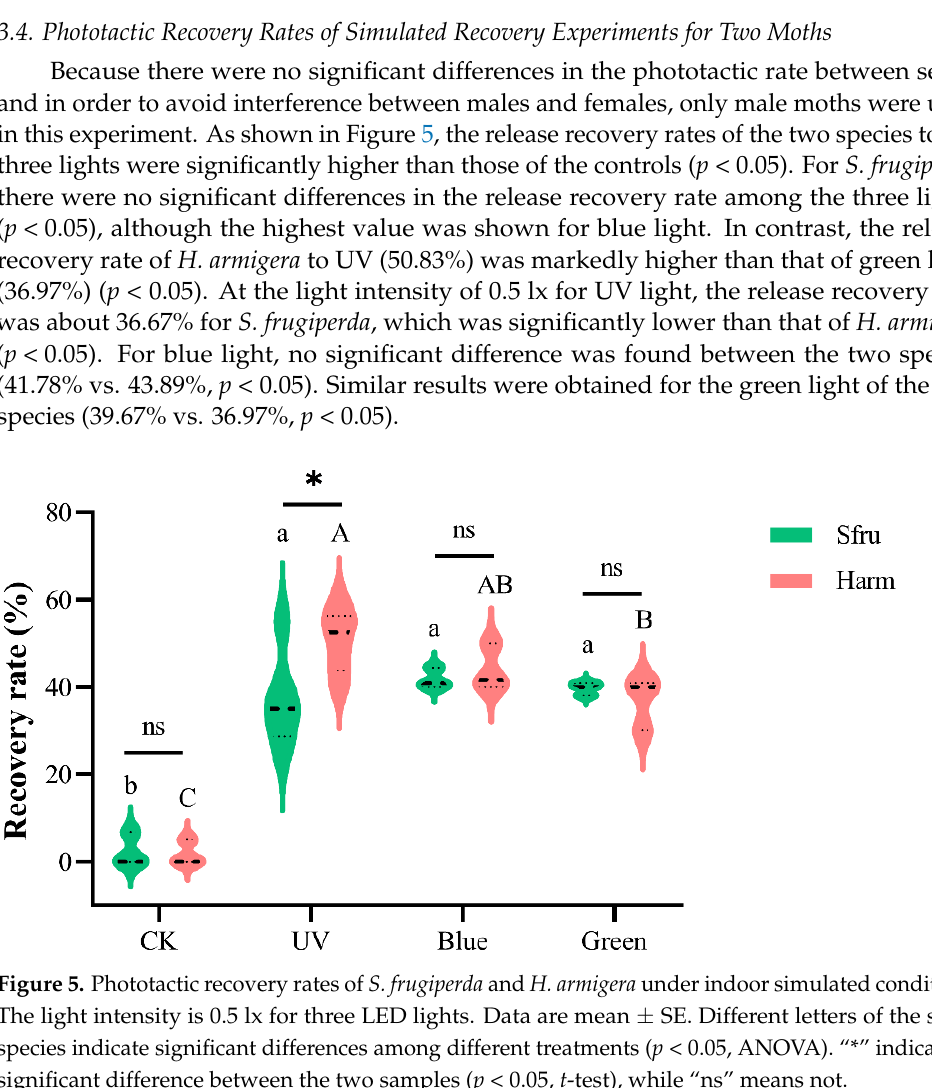
Figure 4. Comparison of phototactic rate between S. frugiperda and H. armigera . ( A – E ), comparison of phototactic rate between S. frugiperda and H. armigera to different wavelength lights under five light intensities (( A ) for UV light; ( B ) for blue light; ( C ) for green light; ( D ) for red light; ( E ) for white light). Data are mean ± SE. “*” indicates a significant difference between the two species under the same condition ( p < 0.05, t -test). UV, UV LED; Blue, blue LED; Green, green LED; Red, Red LED; White, white LED.